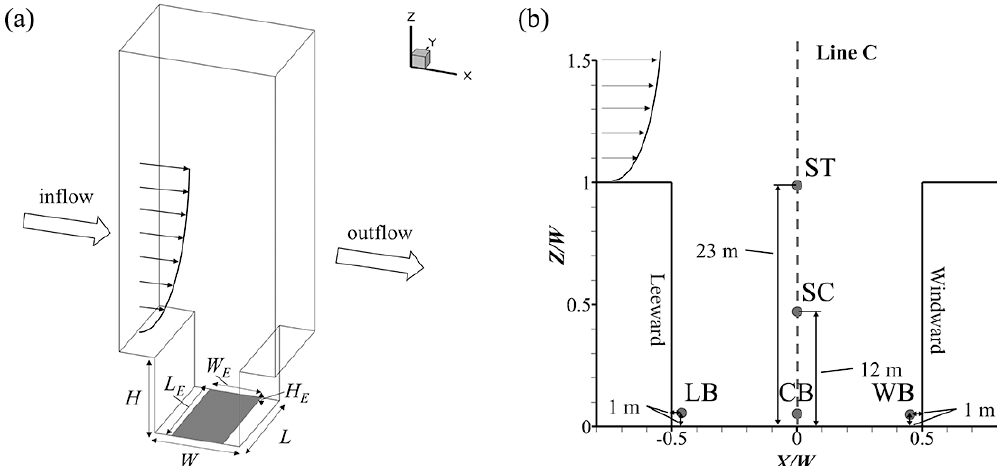
Figure 12. Schematic diagram of (a) the CFD simulation domain and (b) the probe point locations.